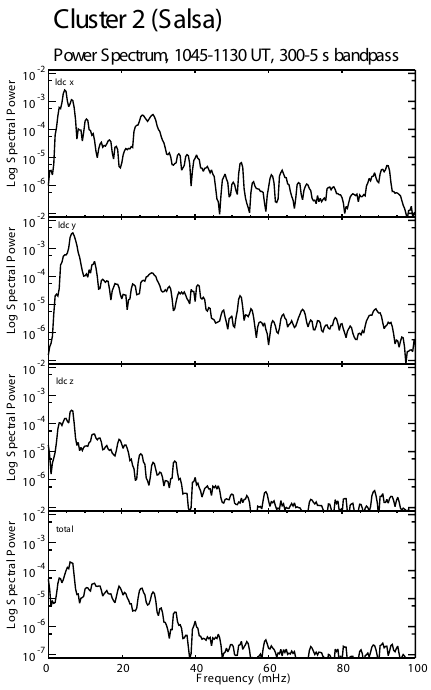
Fig. 5. A Fourier spectrum of the LDC X , Y , Z component and total magnetic field from Cluster 2, from 10:45–11:30 UT, bandpass filtered between 300–5s. Power for each component is indicated on a common logarithmic scale.